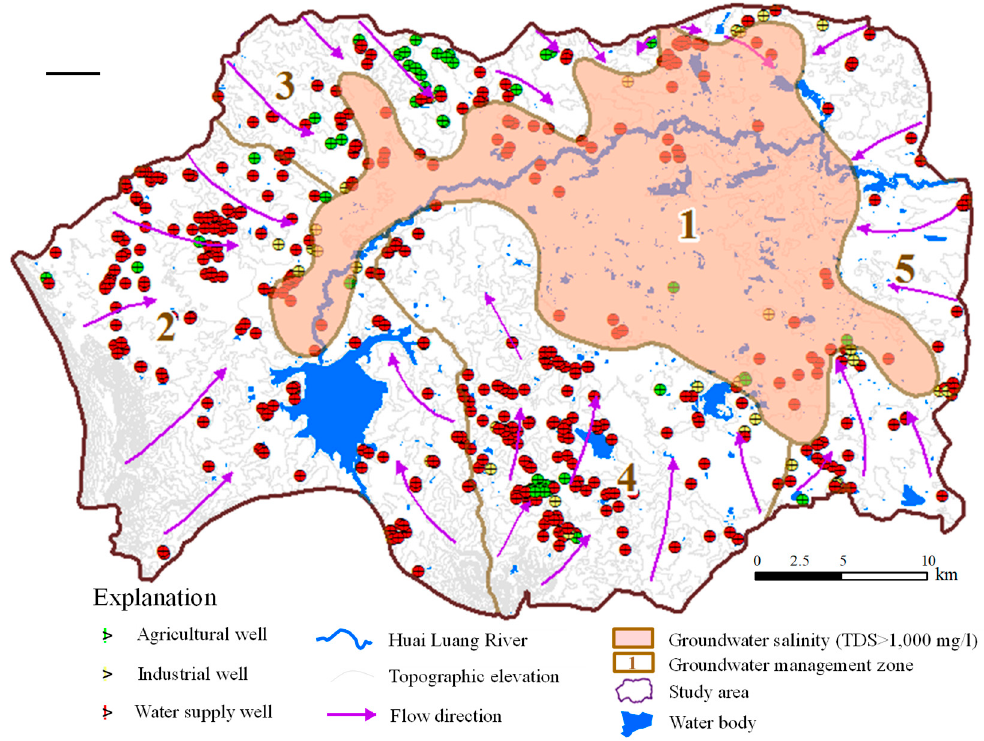
Figure 7. Location of groundwater wells and groundwater management zones .